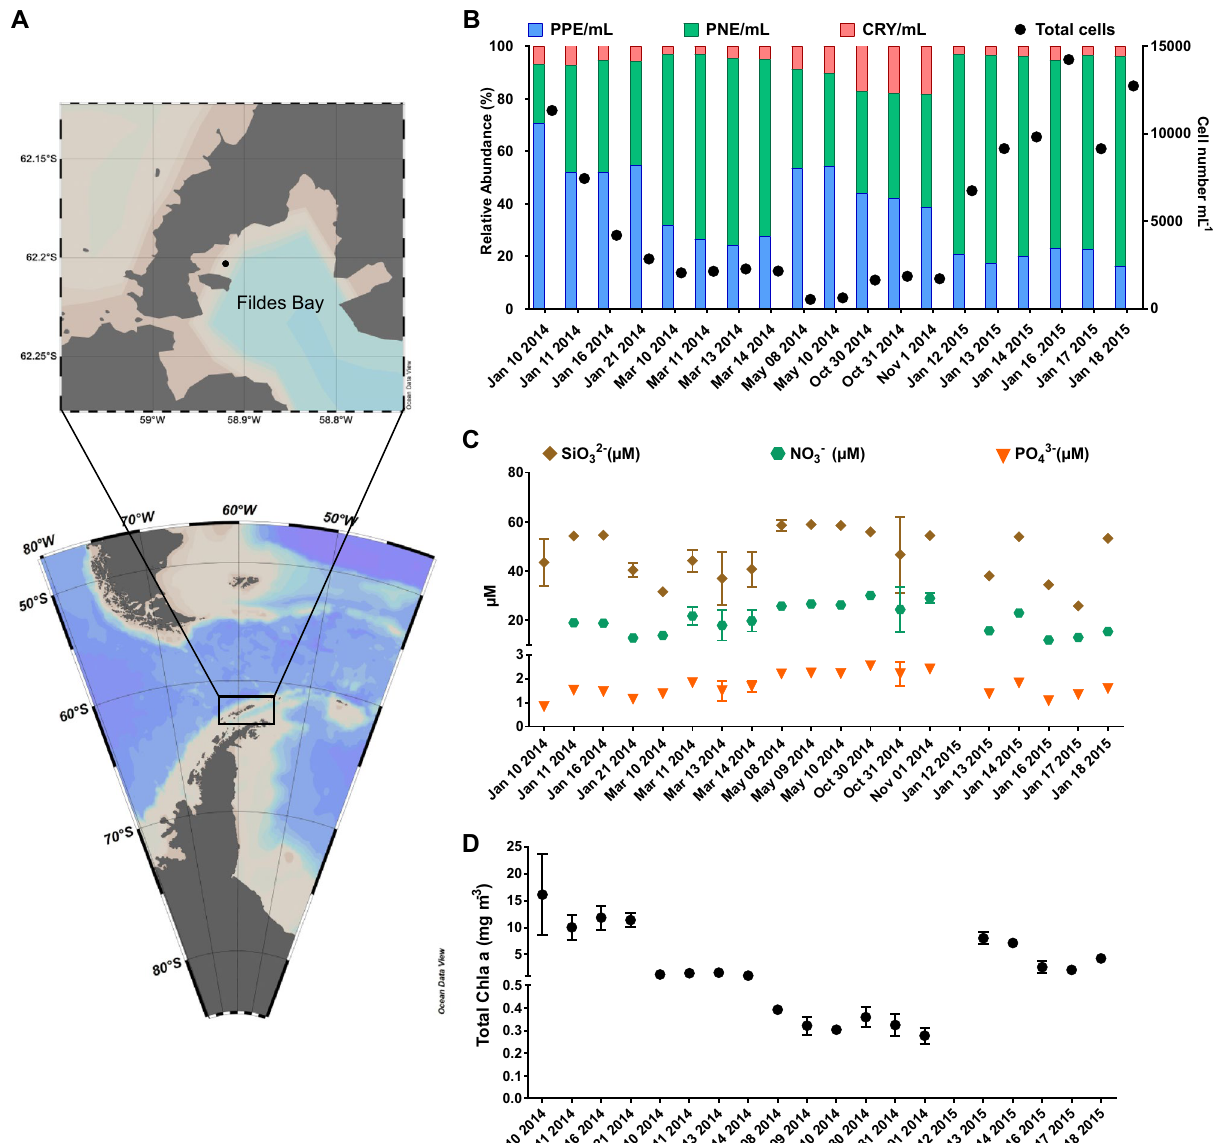
Figure 1. Location of the sampling station (Station 6) in Fildes Bay, King George Island, Western Antarctic